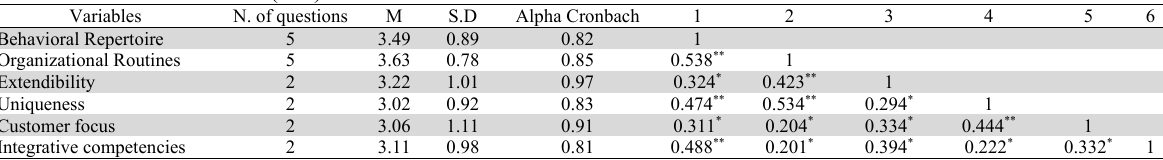
Mean and standard deviation (S.D) and Correlation matrix Variables